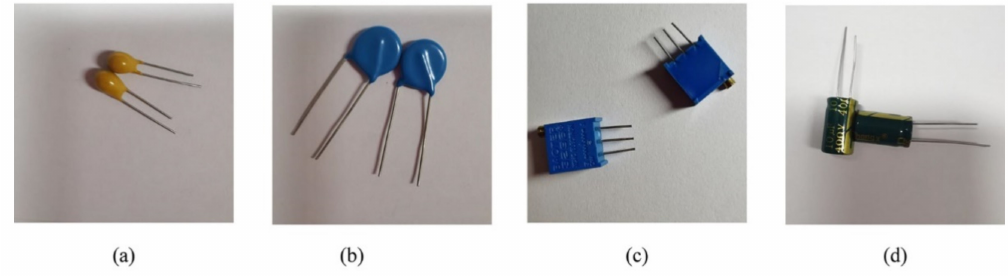
Figure 1. Plug-in electronic components used in the dataset. ( a ) Tantalum capacitor. ( b ) Resistance. ( c ) Potentiometer. ( d ) Electrolytic